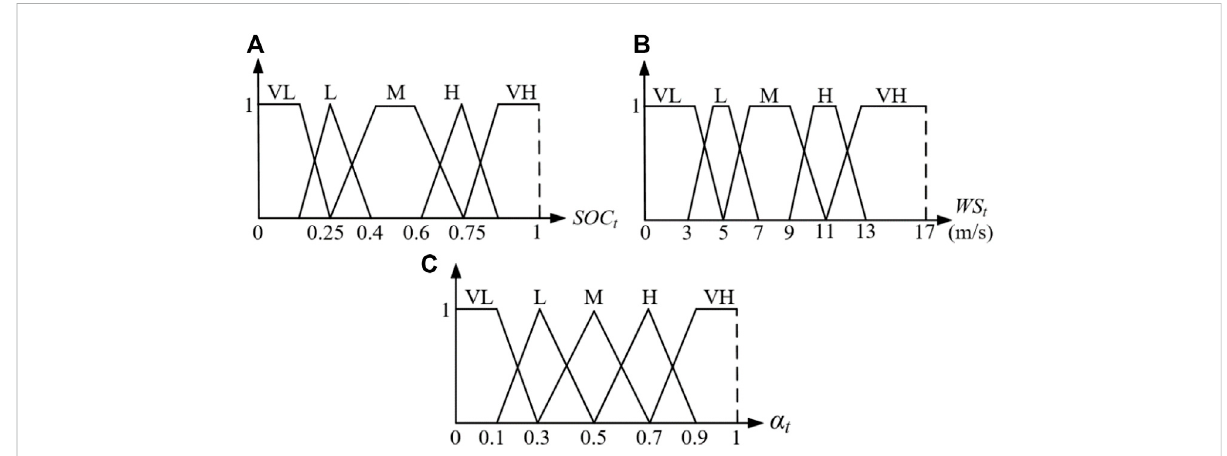
FIGURE 6 Fuzzy membership of FLC2. (A) Fuzzy membership of SOC (B) Fuzzy membership of wind speed (C) Fuzzy membership of FLC2 ’ s output.